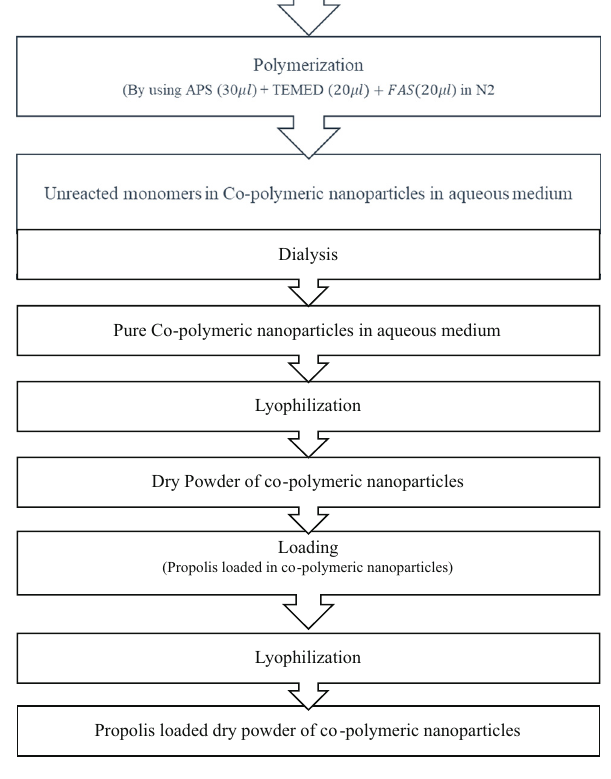
Figure 2: Procedure studied in the preparation of co - polymeric nano - particles. NIPAAM – N - isopropylacrylamide; VP – N - vinyl - 2 - pyrrolidone; PEG - A – poly ( ethyleneglycol ) monoacrylate; MBA – N , N ′ - methylene bis - acrylamide; APS – ammonium persulfate; TEMED – tetramethyl ethy - lene diamine; FAS – ferrous ammonium sulfate [ 76 ]